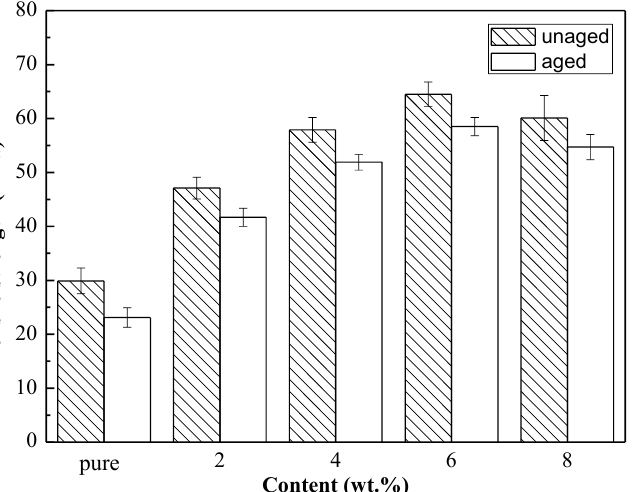
Figure 2. Tensile strength of pure epoxy and composites with different spherical aluminum powder content.